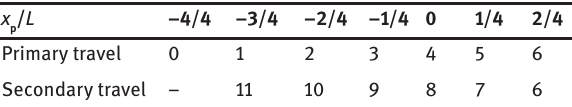
Table 1: Sequence of locations x shell